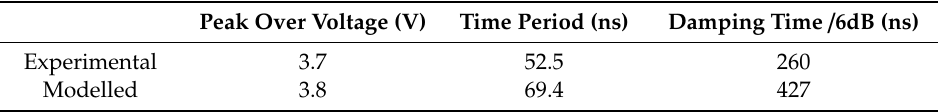
Table 1. Modelled vs Observed Electrical Ringing Characteristics at Contact